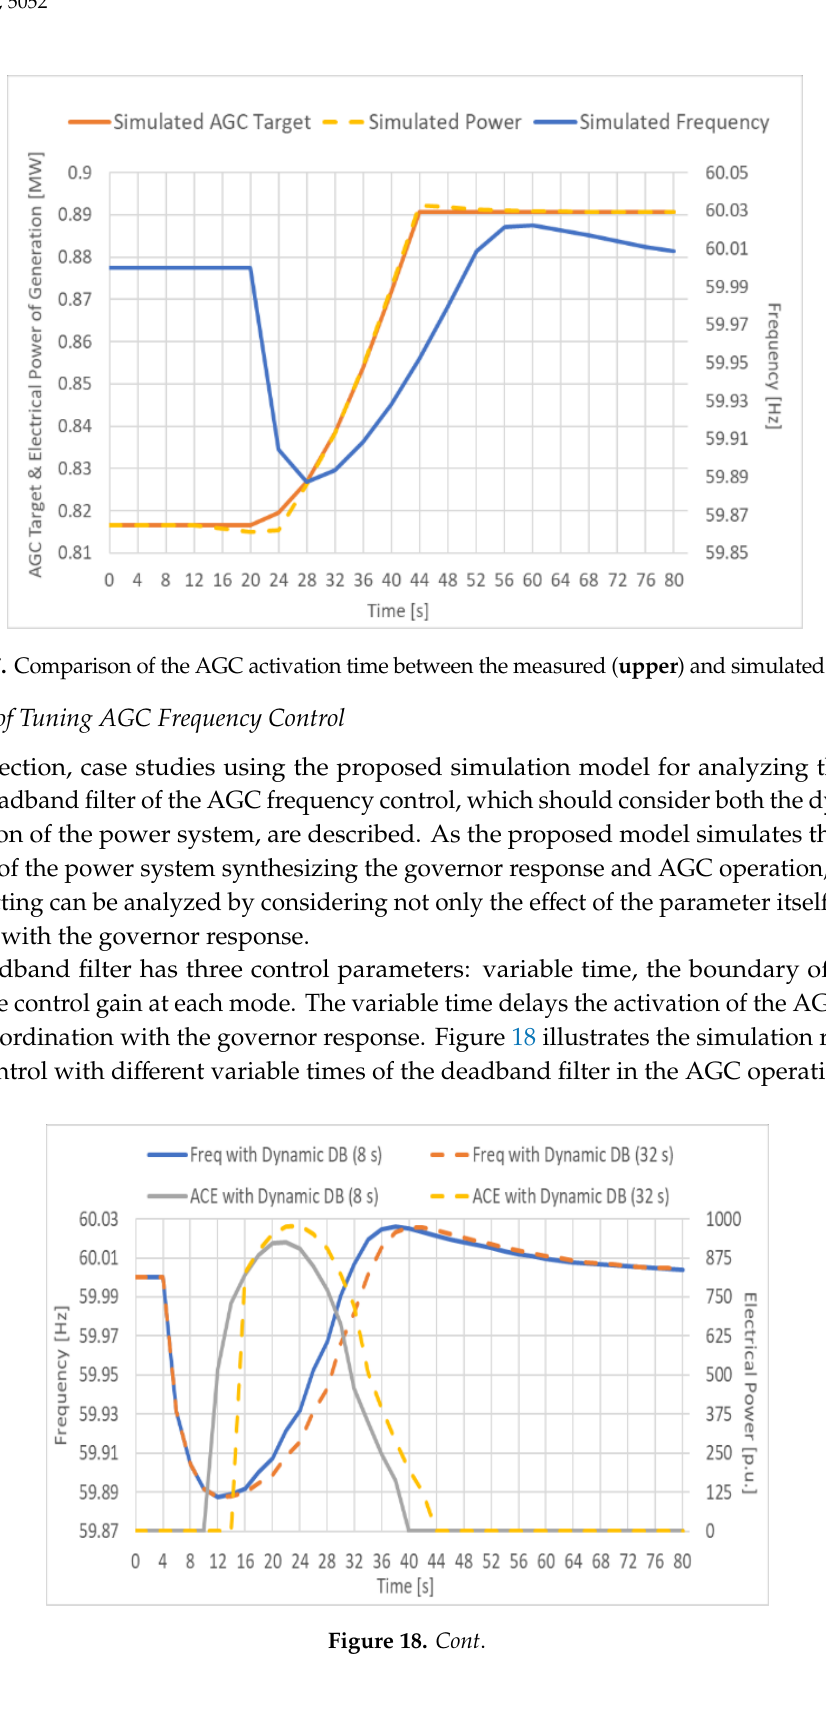
Figure 17. Comparison of the AGC activation time between the measured ( upper ) and simulated ( lower ).